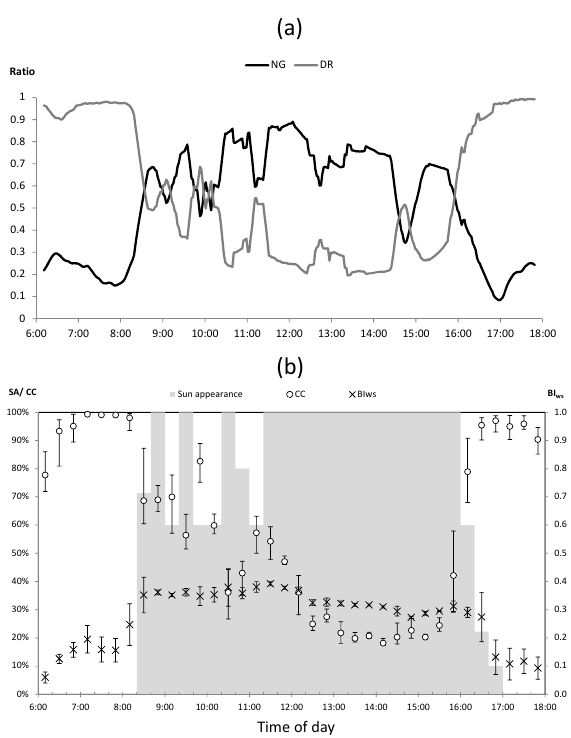
Fig. 2 Diurnal changes of (a) the normalized PAR and diffuse ratio with 20-minute average and (b) cloud conditions at 20- minute interval observed on 26 th Aug. CC is cloud cover. BI ws is whole-sky brightness. Error bar of CC ( BI ws ) shows min-max values (standard deviation).